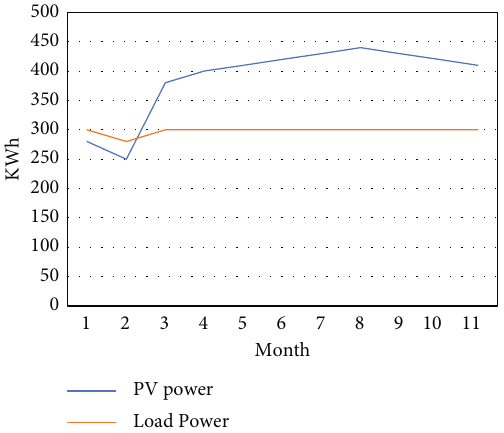
Figure 7: The PV system ’ s regular energy production.